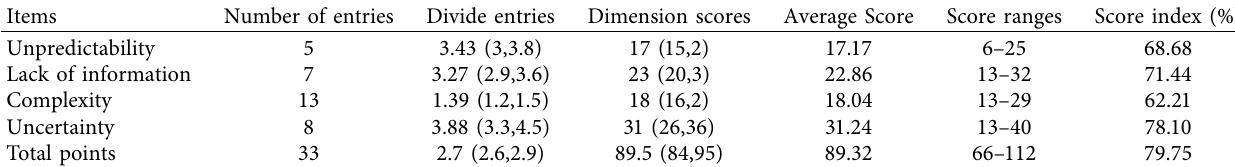
Table 2: Guardian’s MUIS-FM rating.